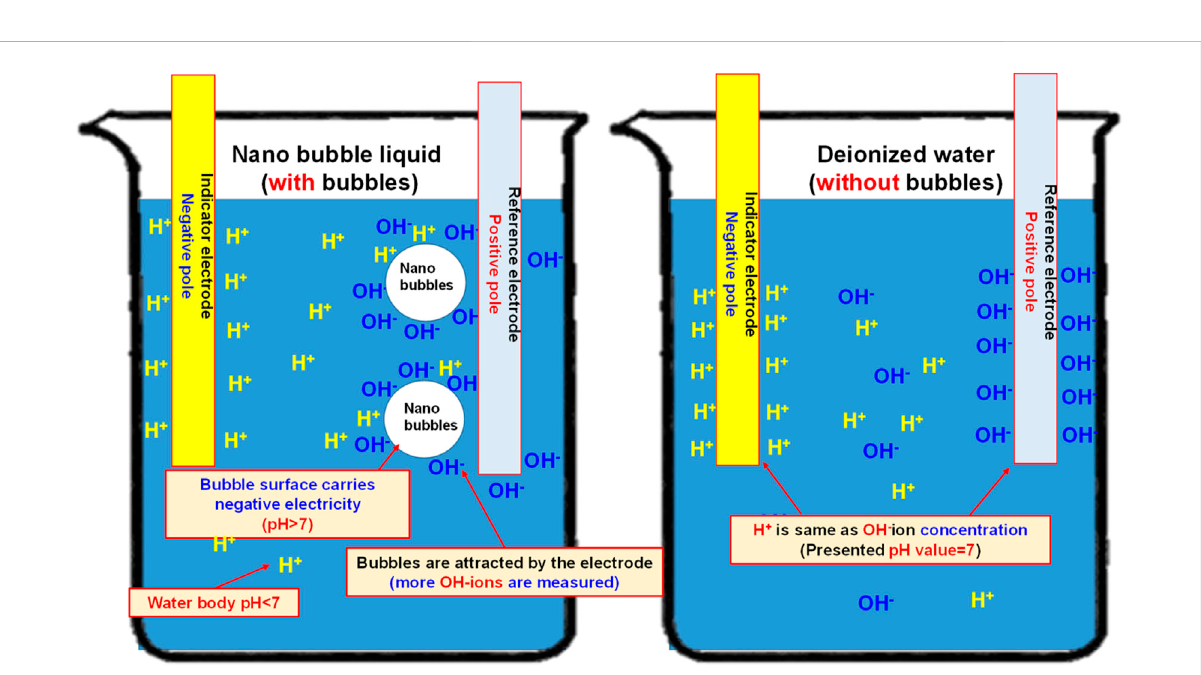
FIGURE 12 Schematic diagram showing the effect of nanobubbles on the measured pH value (if the bubbles in the water solution carry negative potential, pH is higher than 7; if the water body in the water solution is acidifying, pH is less than 7)